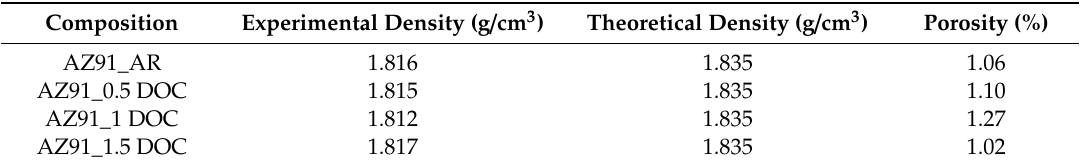
Table 1. Density and porosity results.